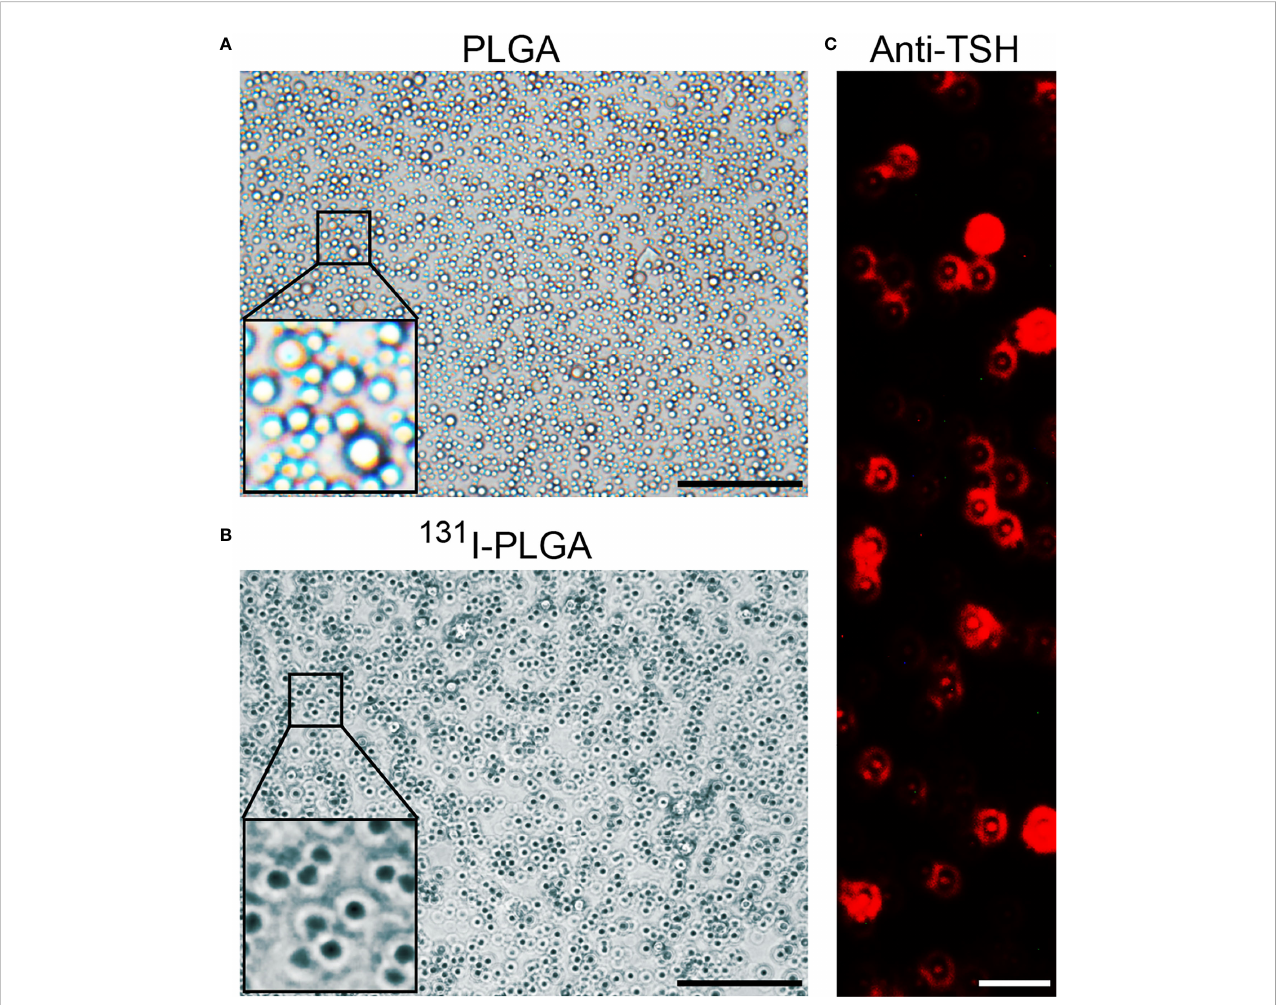
FIGURE 2 The characteristics of 131 I-PLGA-rhTSH nanoparticles. (A) The autoradiography image representing the deposition of black silver particles in PLGA nanoparticles. Scale bar: 5 m m. (B) The autoradiography image demonstrating the accumulation of black silver particles in 131 I-PLGA-rhTSH nanoparticles. Scale bar: 5 m m. (C) The immunostaining of TSH on the surface of 131 I-PLGA-rhTSH nanoparticles.